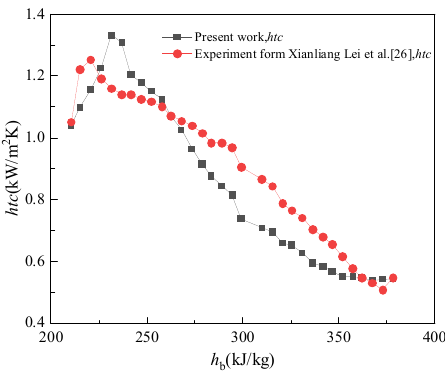
Figure 6. Numerical method validation.